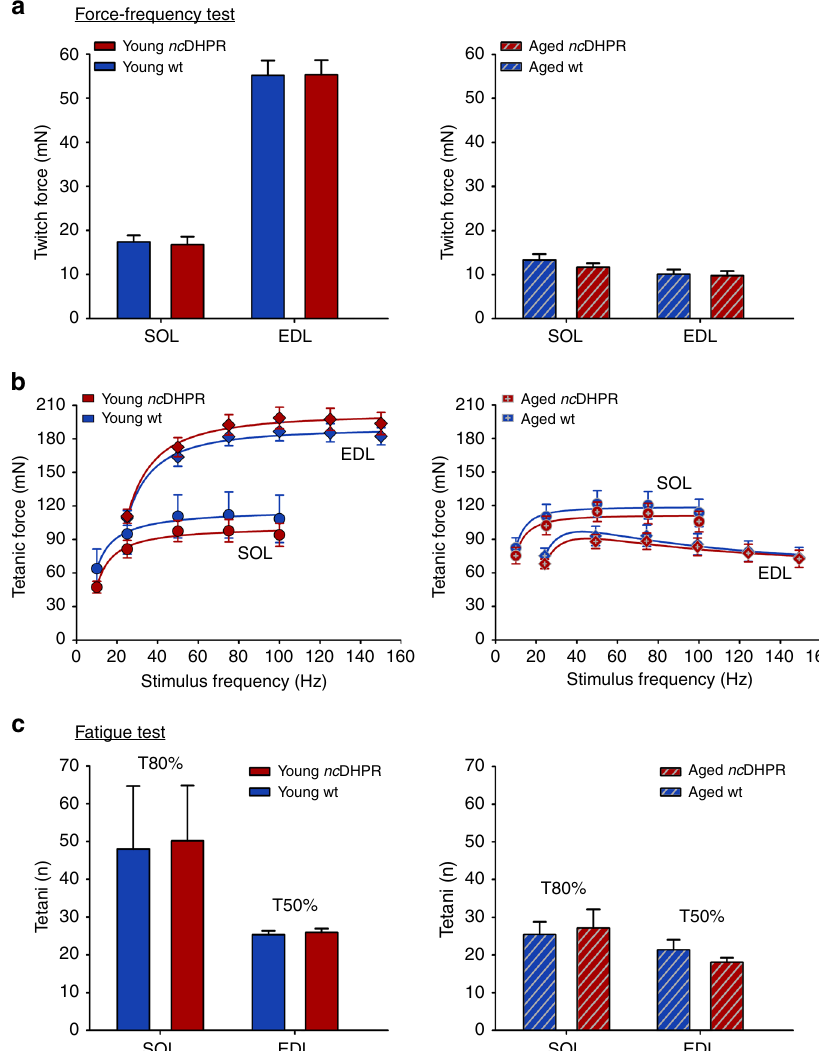
Fig. 6 Absence of DHPR Ca 2+ in fl ux has no impact on ex vivo muscle force and fatigue. Soleus (SOL) and extensor digitorum longus (EDL) muscles isolated from young and aged nc DHPR and wt control mice were subjected to ( a , b ) force-frequency and c repetitive tetanic fatigue tests (see also Supplementary Fig. 7). a The average maximum twitch force (at supramaximal voltage, 25 V for 1 ms) is identical ( P > 0.05) in SOL and EDL muscles between young ( left graph ) nc DHPR (SOL: 16.78 ± 1.80 mN; n = 12; EDL: 55.33 ± 3.31 mN; n = 19) and wt (SOL: 17.39 ± 1.49 mN: n = 9; EDL: 55.14 ± 3.39 mN: n = 18) mice, as well as between aged ( right graph ) nc DHPR (SOL: 11.66 ± 0.91 mN; n = 19 and EDL: 9.76 ± 1.04 mN; n = 20) and wt (SOL: 13.33 ± 1.35 mN; n = 18 and EDL: 10.09 ± 1.06 mN; n = 22) mice. b Frequency dependence of average tetanic force in SOL and EDL muscles is also unaltered ( P > 0.05) between age- matched nc DHPR and wt mice ( left and right graphs ). c Under high-frequency repetitive stimulations, the number of tetani till the tetanus amplitude decreased to 80% (T80%) of the initial force in case of SOL and 50% (T50%) for EDL was taken as an index of fatigue. No difference in susceptibility to fatigue was observed in SOL and EDL muscles isolated from either young ( left graph ) nc DHPR (SOL: T80% = 50.12 ± 14.65 n; n = 12; EDL: T50% = 25.95 ± 1.04 n; n = 19) and wt (SOL: T80% = 48.0 ± 16.66 n; n = 9; EDL: T50% = 25.33 ± 1.05 n; n = 18) mice or aged ( right graph ) nc DHPR (SOL: T80% = 27.22 ± 4.89 n; n = 18; EDL: T50% = 18.12 ± 1.14 n; n = 17) and wt (SOL: T80% = 25.5 ± 3.31 n; n = 18; EDL: T50% = 21.42 ± 2.61 n; n = 19) mice. All recordings were performed at room temperature (~26 °C). Data are represented as mean ± s.e.m.; P determined by unpaired Student ’ s t